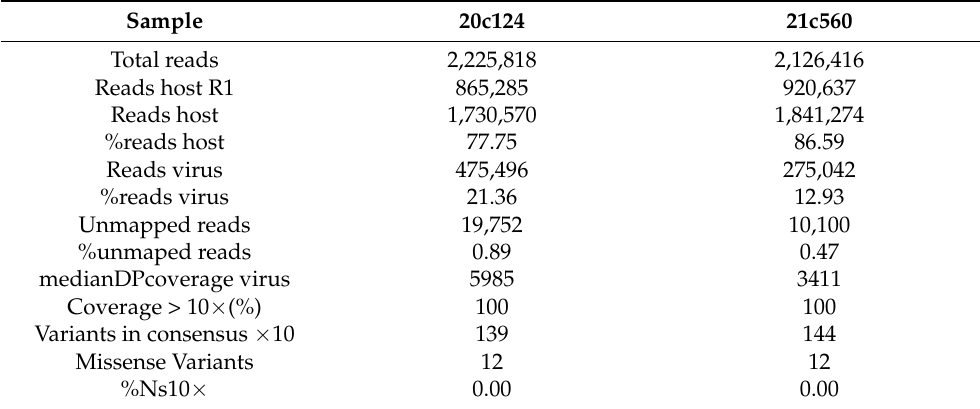
Table 1. Raw sequencing data, where the host are Vero Cells, and the reference sequence is